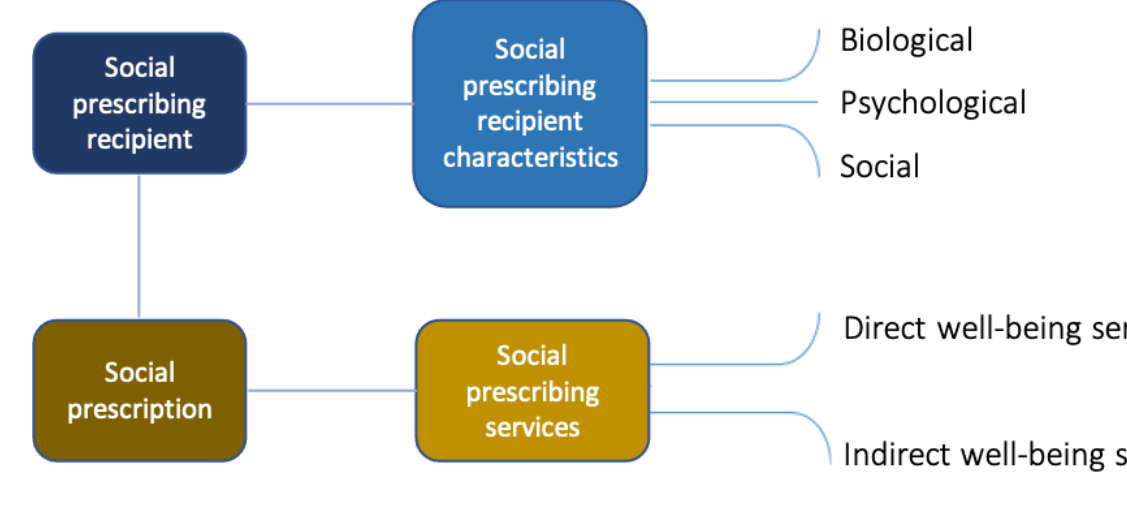
Table 1. Social prescribing ontological categories and unique primary codes (N=668) for each category.